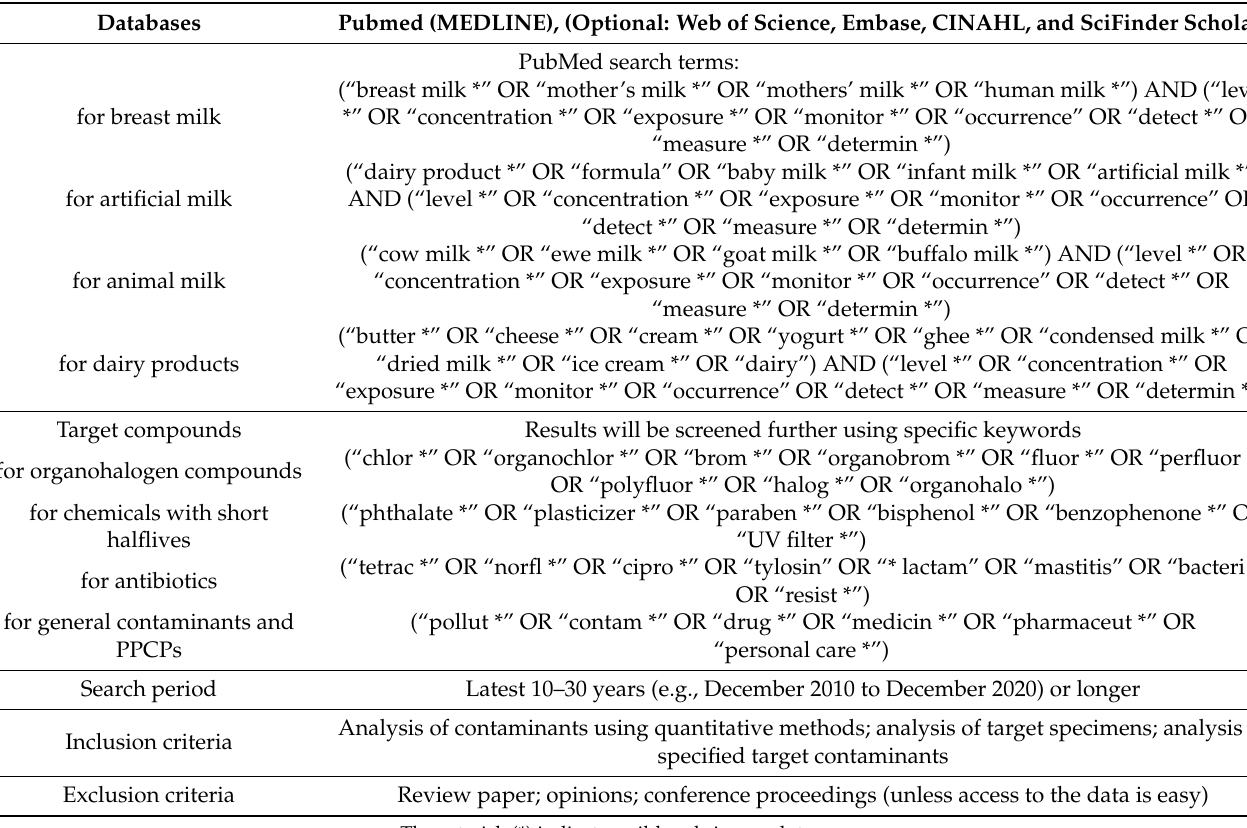
Table 1. Search strategy in the proposed